Question: What style of plot is this figure drawn as?
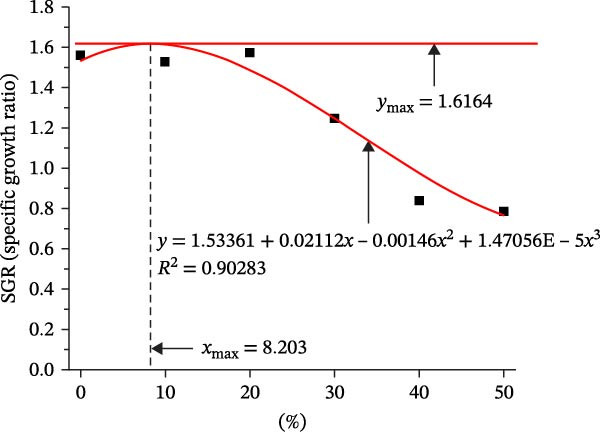
Answer: line